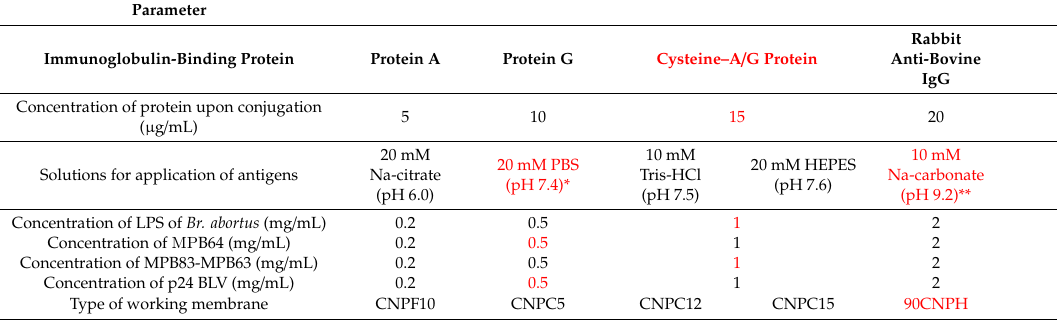
Table 1. Optimization of ICA conditions (selected parameters are highlighted (red) in color).